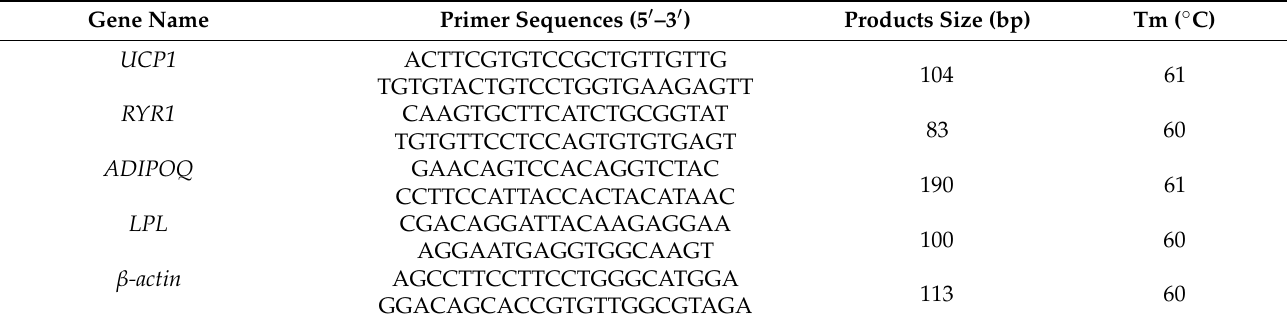
Table 1. Primer sequences for amplification of selected genes for RT-PCR